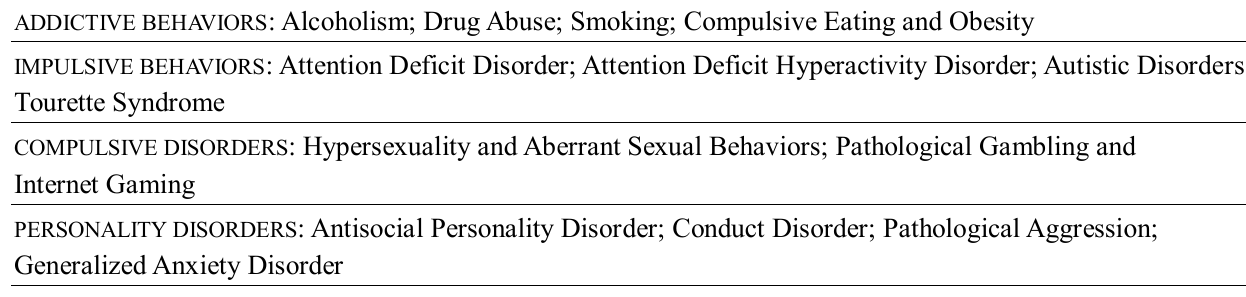
Table 1. Examples of behaviors and disorders [1-4,11,12,27,32,33,105-114, 116-140,185,186,196,210,213] associated with Reward Deficiency